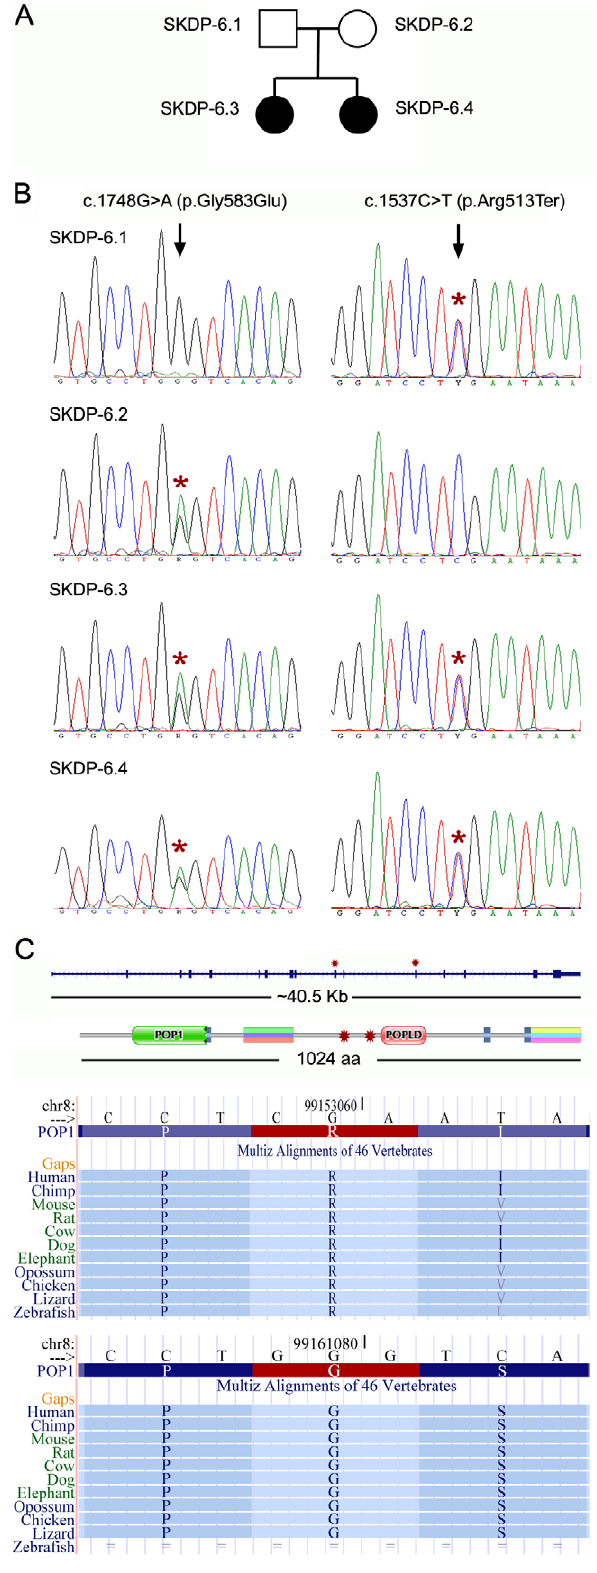
Figure 2. Mutations in the POP1 gene. (A) Pedigree of the studied family. (B) SKDP-6.1 and SKDP-6.2 indicate sequences from non-affected parents. SKDP-6.3 and SKDP-6.4 indicate sequences from two affected siblings. Black arrowheads show positions of the mutated